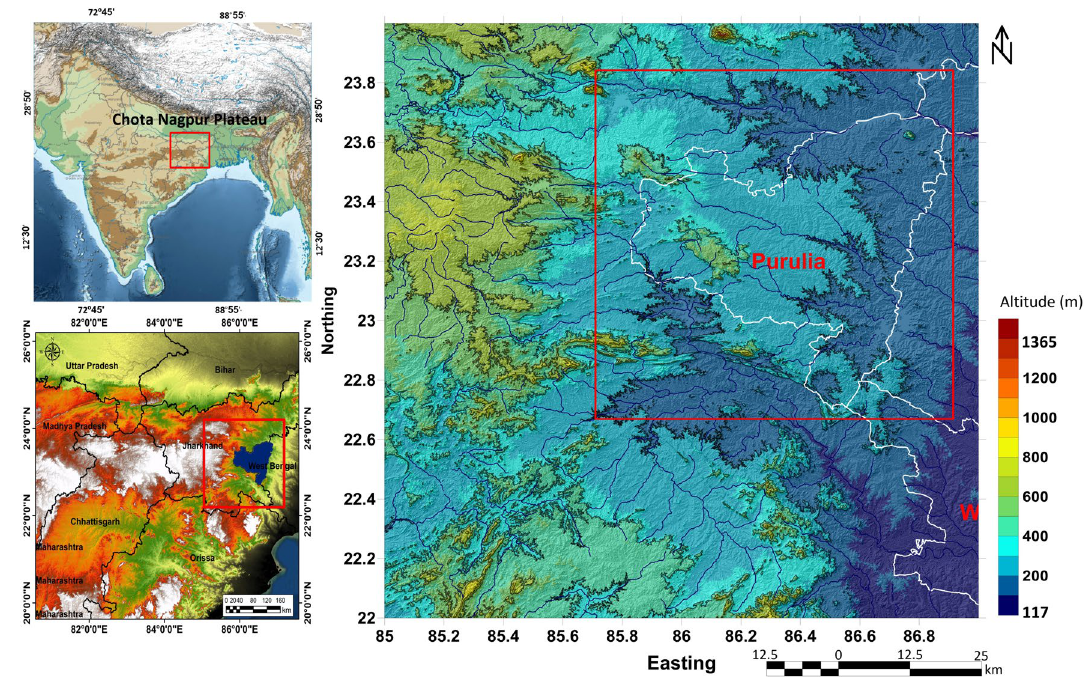
Fig. 1 Geographical location of the study